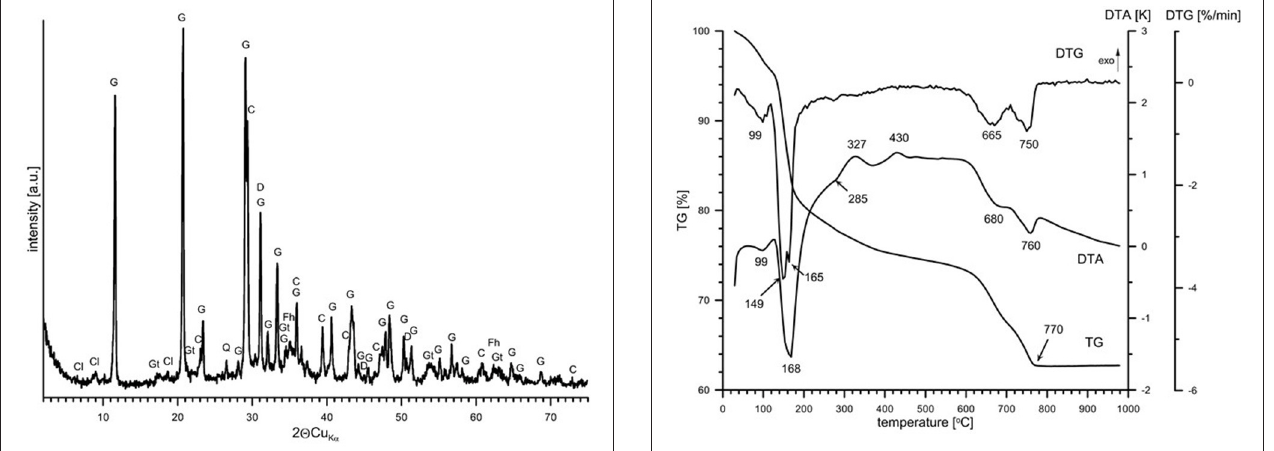
FIGURE 2 | XRD pattern of the gBIOs. Explanations: G, gypsum; C, calcite; Gt, goethite; Fh, ferrihydrite; D, dolomite; C1, clay minerals.